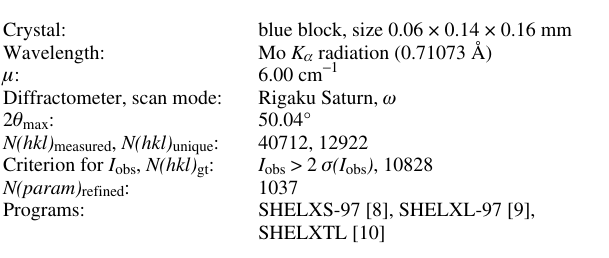
Table 1. Data collection and